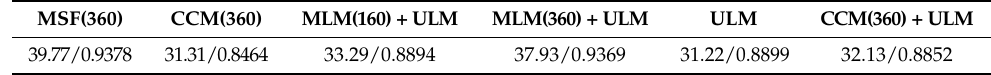
Table 3. The average PSNR/SSIM results on six